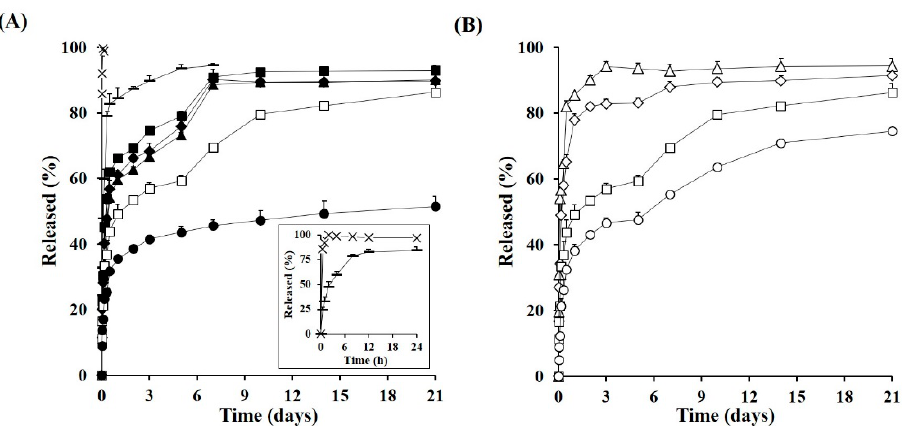
Figure 3. In vitro release profile of TA from the novel MSs under accelerated conditions (45 °C). ( A ) Figure 3. In Vitro release profile of TA from the novel MSs under accelerated conditions (45 ◦ C). Drug release profile from the marketed product (×), 7.2 μ m-sized TA crystals-loaded MS (F0, –), and ( A ) Drug release profile from the marketed product ( × ), 7.2 µ m-sized TA crystals-loaded MS (F0, –), and 1.7 μ m-sized TA crystals-loaded MS prepared with different PLGA:PLA ratios; 4:0 (F1,  ), 3:1 (F2, 1.7 µ m-sized TA crystals-loaded MS prepared with di ff erent PLGA:PLA ratios; 4:0 (F1, (cid:4) ), 3:1 (F2, (cid:7)